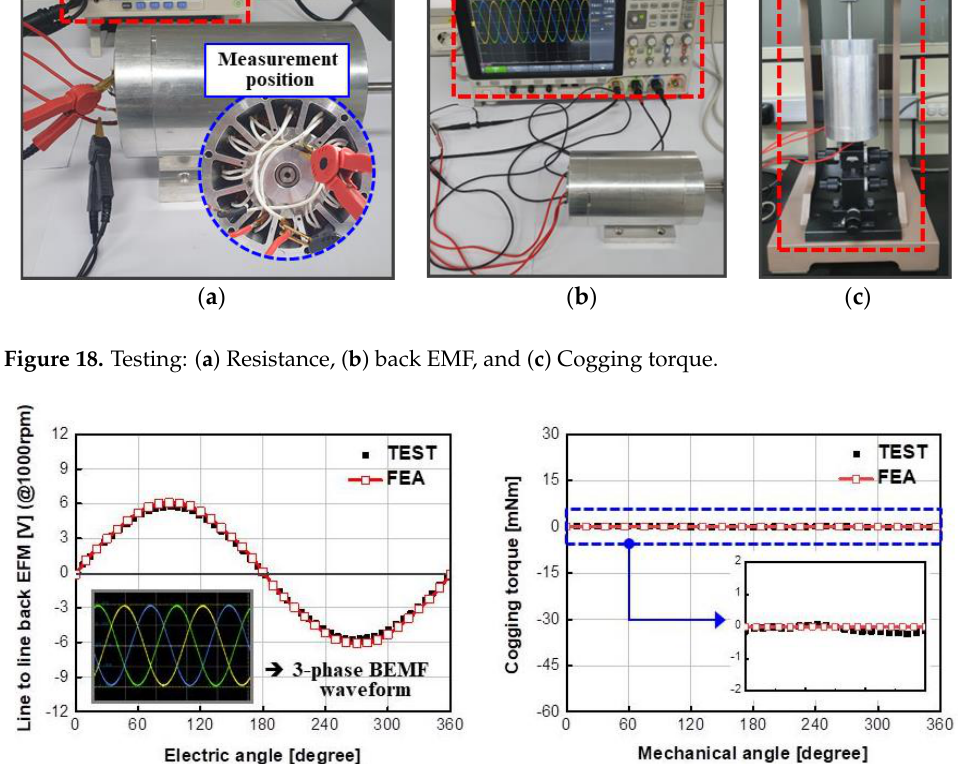
Figure 18. Testing: ( a ) Resistance, ( b ) back EMF, and ( c ) Cogging torque.